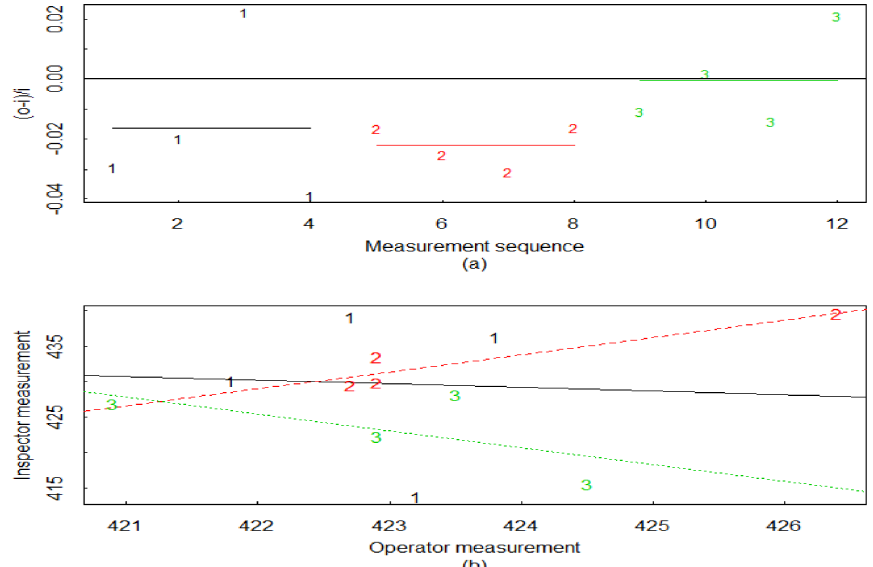
Fig. 2. Example real veri fi cation measurement data. (a) Four paired ( O , I ) measurements in three inspection periods; (b) inspector vs. operator measurement by group, with linear fi ts in each